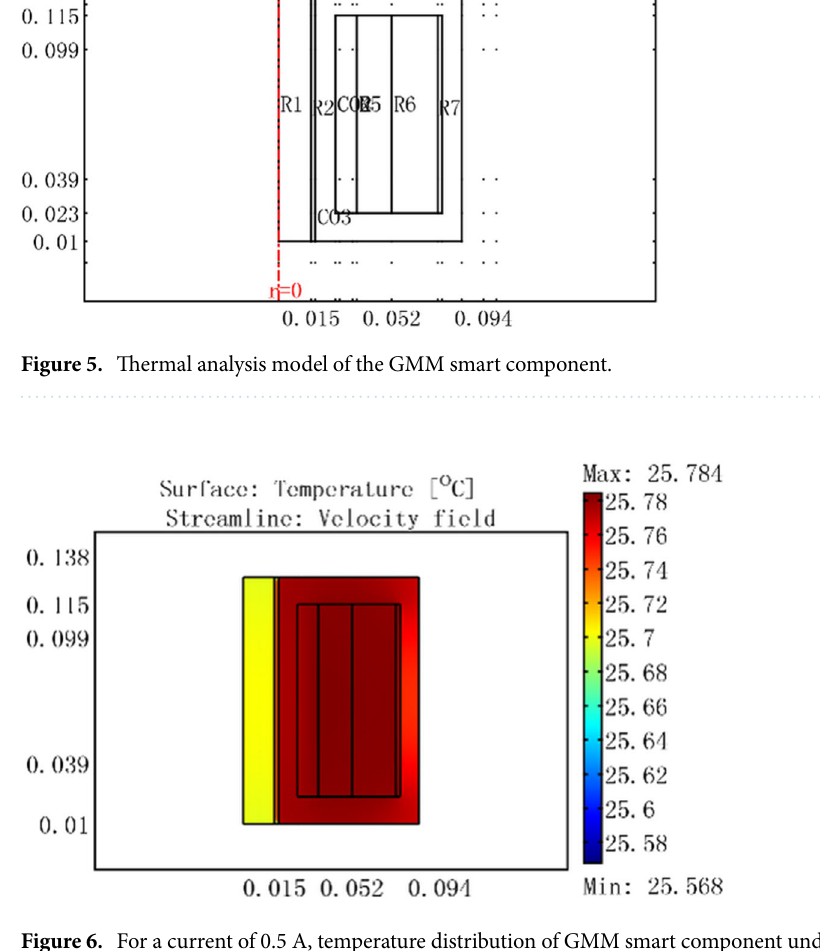
Figure 6. For a current of 0.5 A, temperature distribution of GMM smart component under no cooling